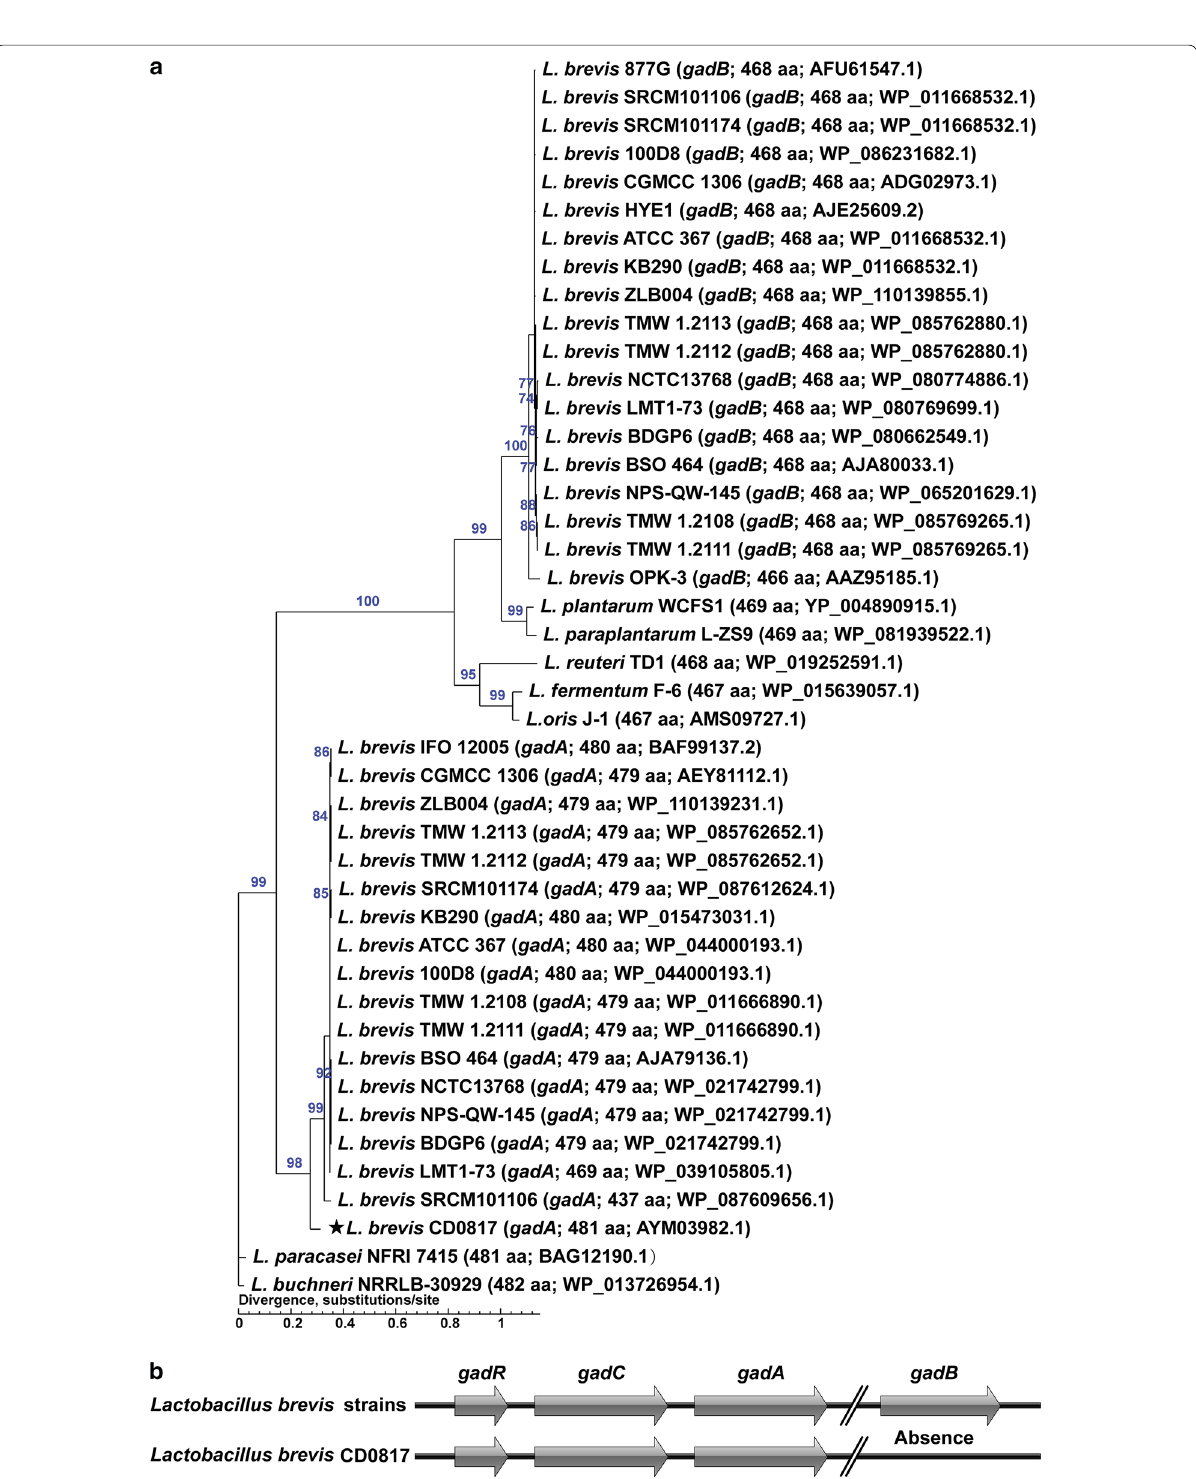
Fig. 6 GAD analysis of CD0817 and 27 reference lactobacilli strains. a The maximum-likelihood tree based on amino acid sequences of GAD genes. Bootstrap values higher than 70% are shown at branch points. The length and GenBank accession numbers of GAD genes from each strain are shown in brackets. b Arrangements of GAD genes from CD0817 or other completely sequenced Lactobacillus brevis strains. gadR , transcriptional regulator gene; gadC , glutamate/GABA antiporter gene; gadA / gadB , GAD